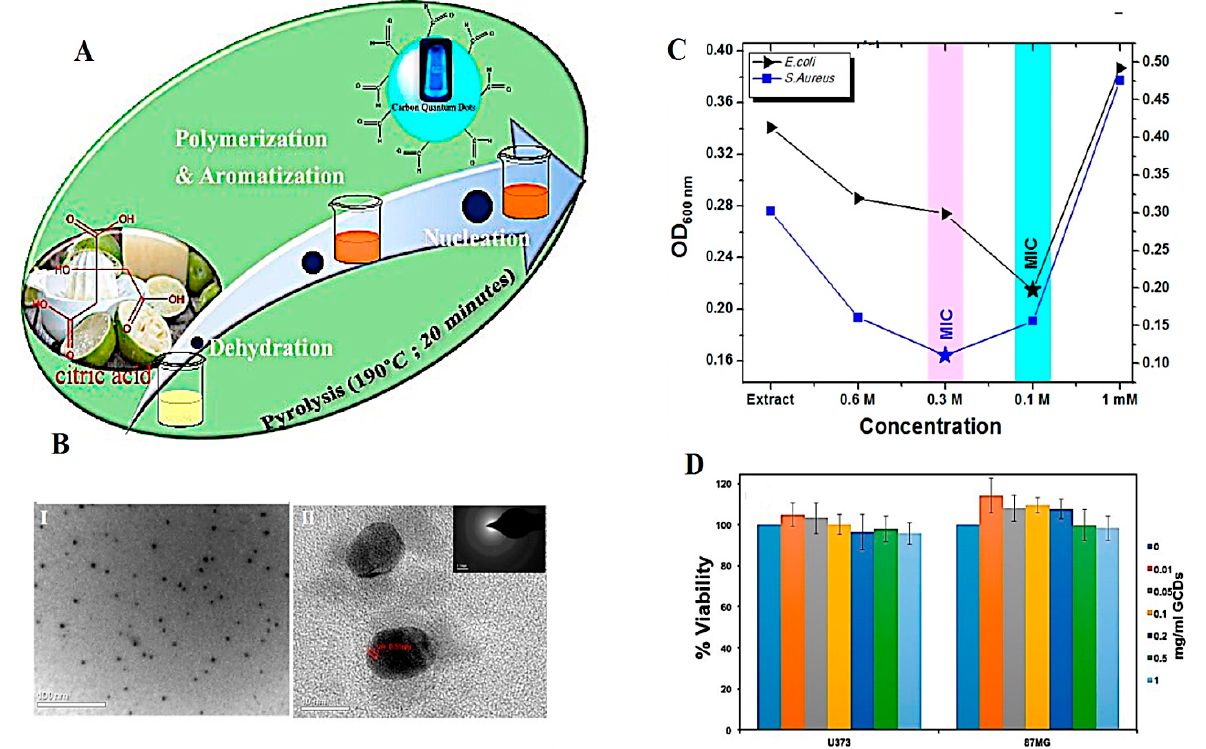
Figure 2. ( A ) The preparative process of CDs using C. Limetta waste pulp. ( B ) ( I ) High-resolution transmission electron microscopy (HR-TEM) image (scale bar: 100 nm), ( II ) lattice fringe analysis (scale bar: 10 nm). ( C ) OD 600 measurements of bacterial cultures incubated with CDs with different mM for analyzing minimum inhibitory concentration (MIC). ( D ) The viability analysis of cells treated with CDs using CKK8 assay. Reproduced with permission from Ref [37]. Copyright 2018 American Chemical Society.